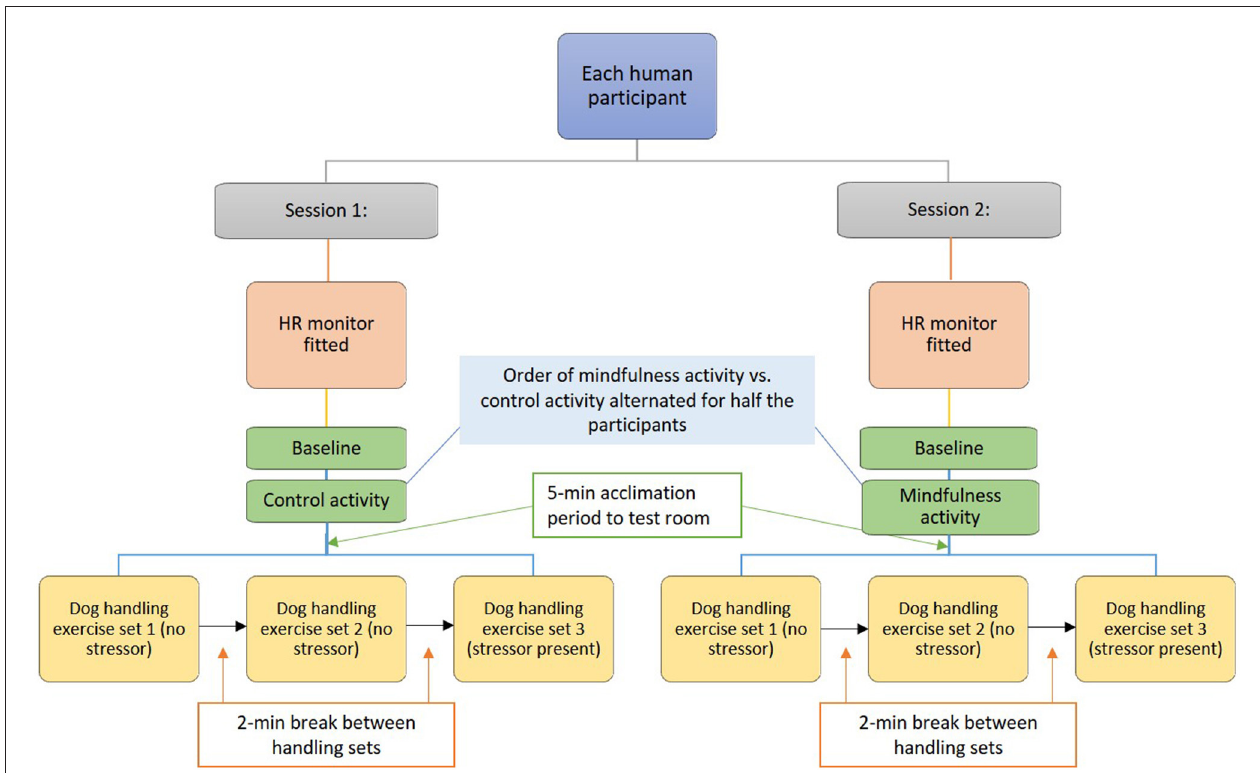
FIGURE 1 | Sequence of data collection sessions and handling